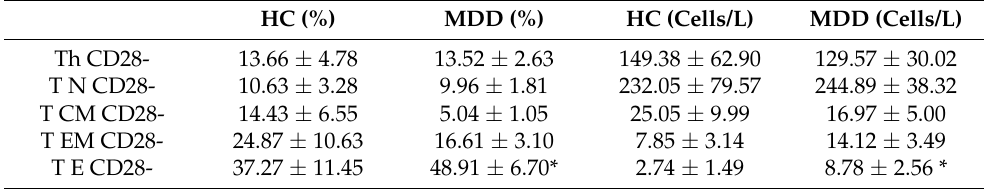
Table 3. Circulating counts and percentages of CD28-CD4 + T lymphocytes and of their T N , T CM , T EM and T E subsets in MDD patients and HCs. * represent p < 0.05 between MDD patients and